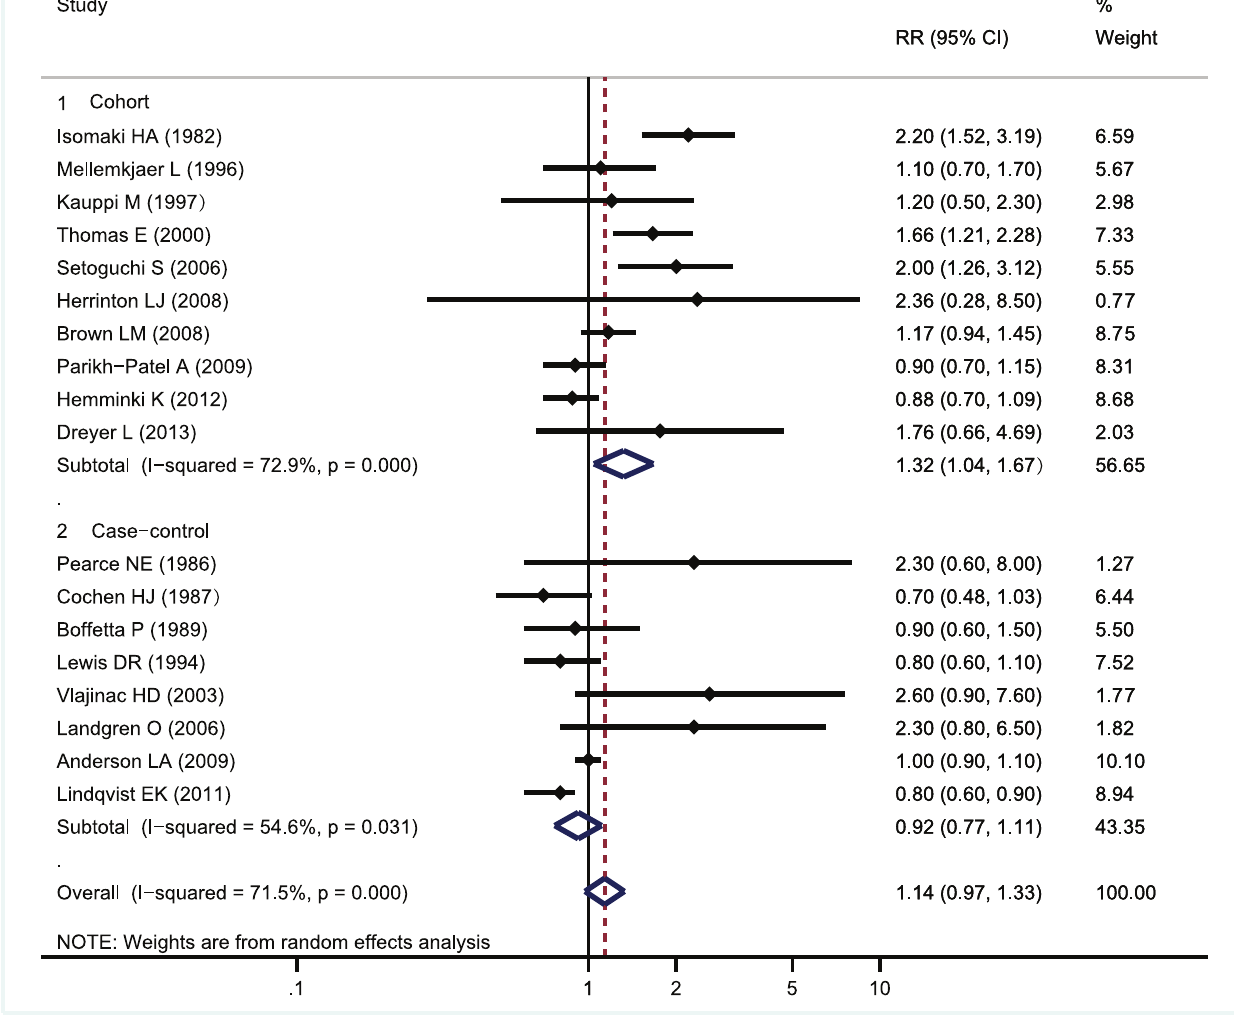
Figure 2. Forest plot of studies on multiple myeloma development risk in rheumatoid arthritis.